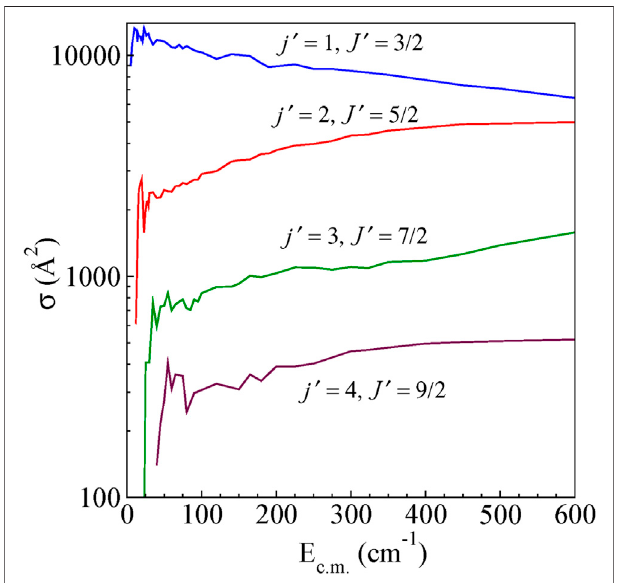
FIGURE 5 | State-to-state integral cross sections for rotational excitationsfor Δ J ≠ Δ j transitionsfromtheinitiallevel j (cid:1) 0and J (cid:1) ½forH + + CN ( j (cid:1) 0 , J (cid:1) ½) → H + + CN ( j ′ ,J ′ )